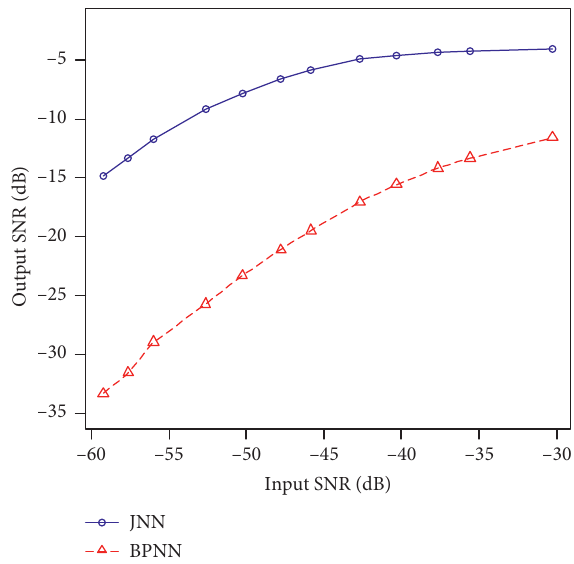
Figure 7: Output SNR vs. input